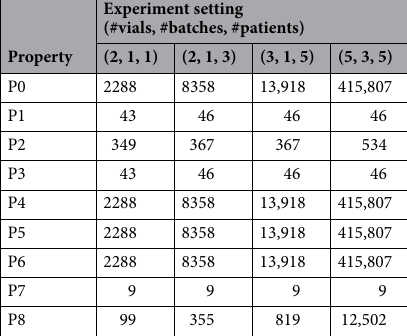
Table 5. Number of states visited in verifying each property.